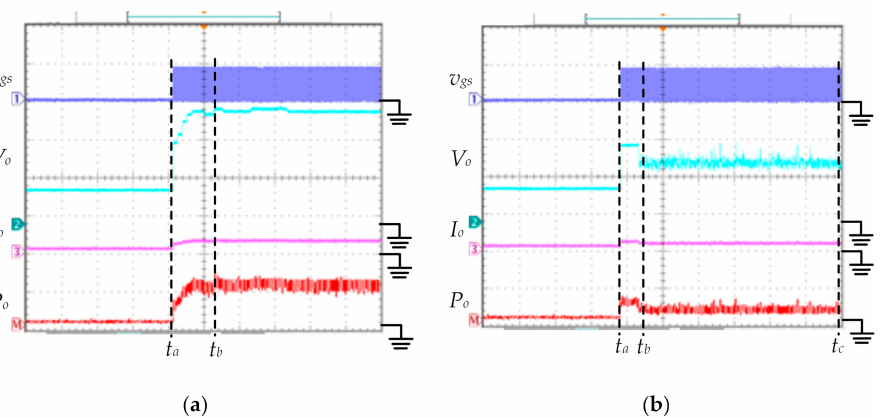
Figure 10. Experimental waveforms of v gs , V o , I o , and P o under UIC that T = 60 ◦ C and G = 0.2 kW/m 2 : ( a ) proposed PVM-QR MPPT and ( b ) HC algorithms. ( v gs : 20 V/div; V o : 10 V/div; I o : 2.5 A/div; P o : 20 W/div; and Hor: 1